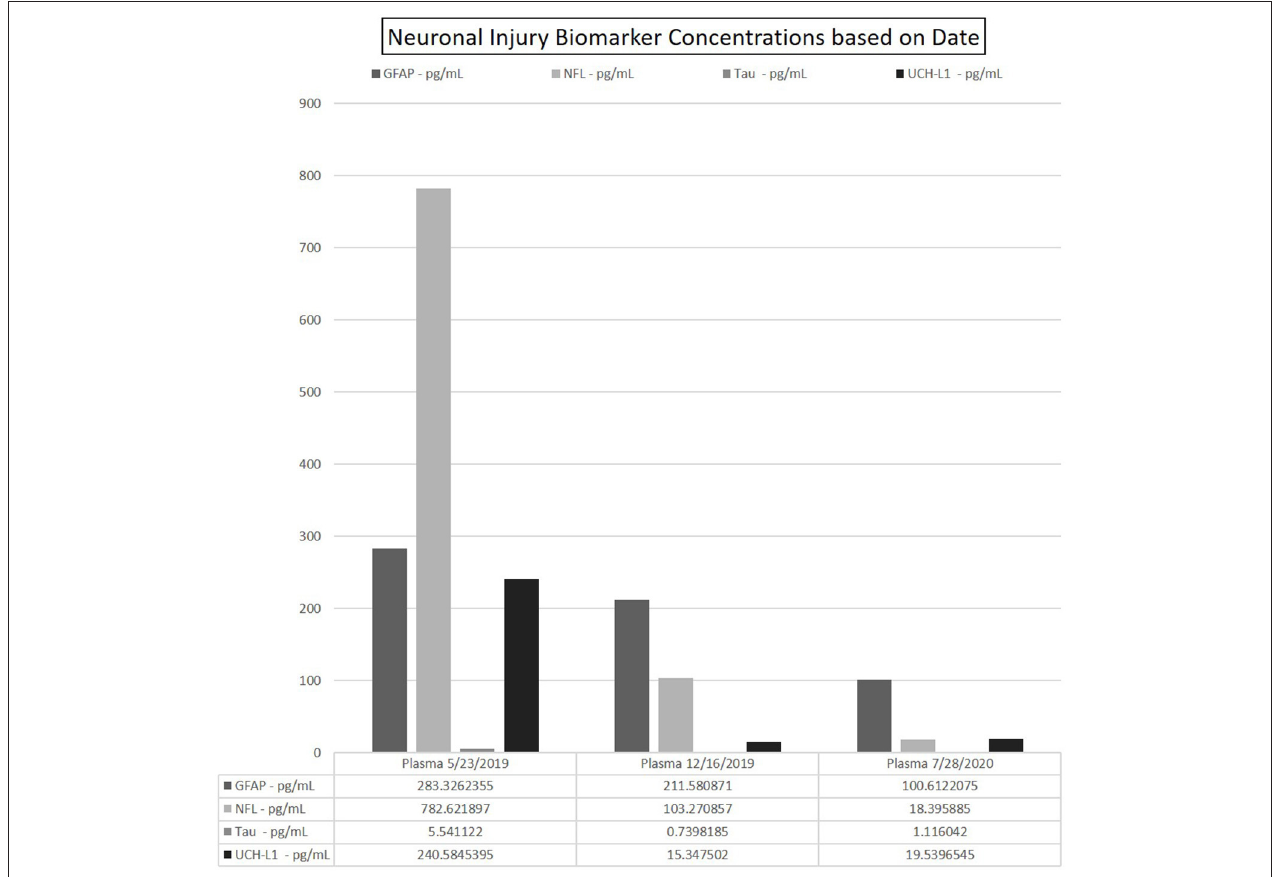
FIGURE 3 | Data depicting the fitted concentration values for GFAP, NFL, Tau, and UCH-L1 at time points 0–6–14 months. Date of sample collection utilized to represent these time points. Each run yielded 2-well readings on the N4PA; the averaged of each shown for clarity. CSF omitted from table due to exceedingly high concentrations of NfL as compared with the values in the patients’